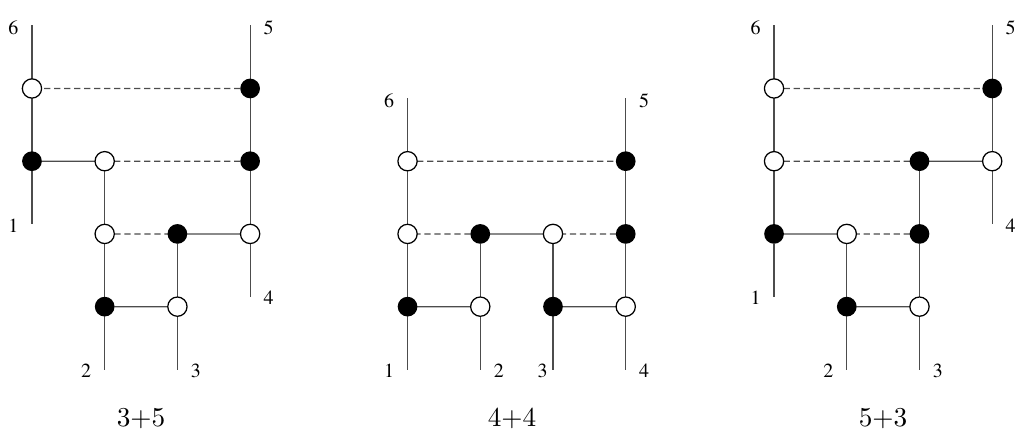
Figure 15 . Decorated planar on-shell diagrams contributing to the 6 point NMHV amplitude in N = 8 SUGRA. The full amplitude can be obtained by summing over permutations of legs 1 to